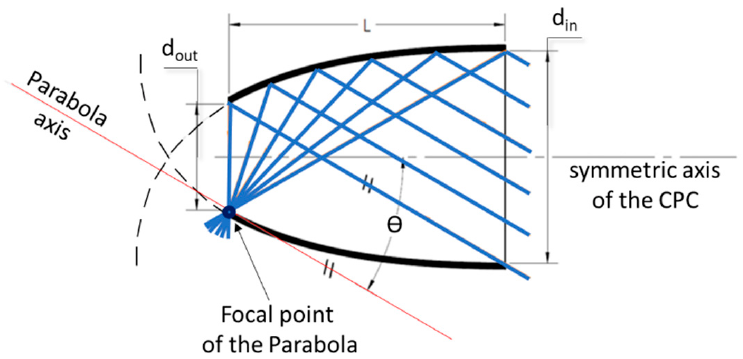
Figure 3. The structure and design concept of the CPC.